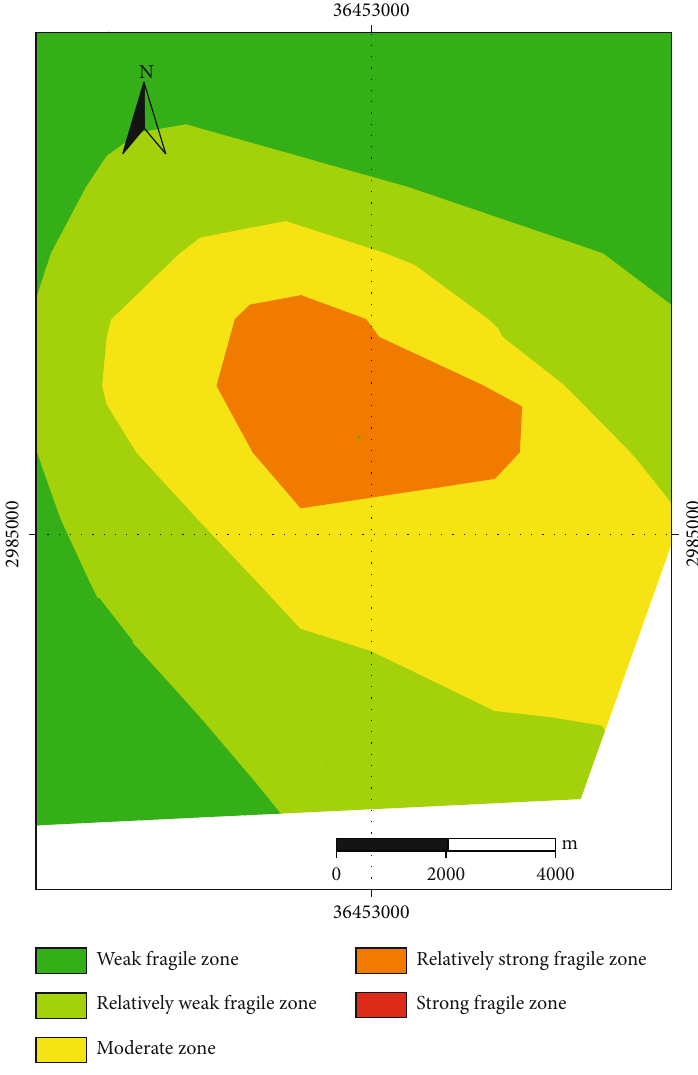
Figure 7: Partial enlarged map based on